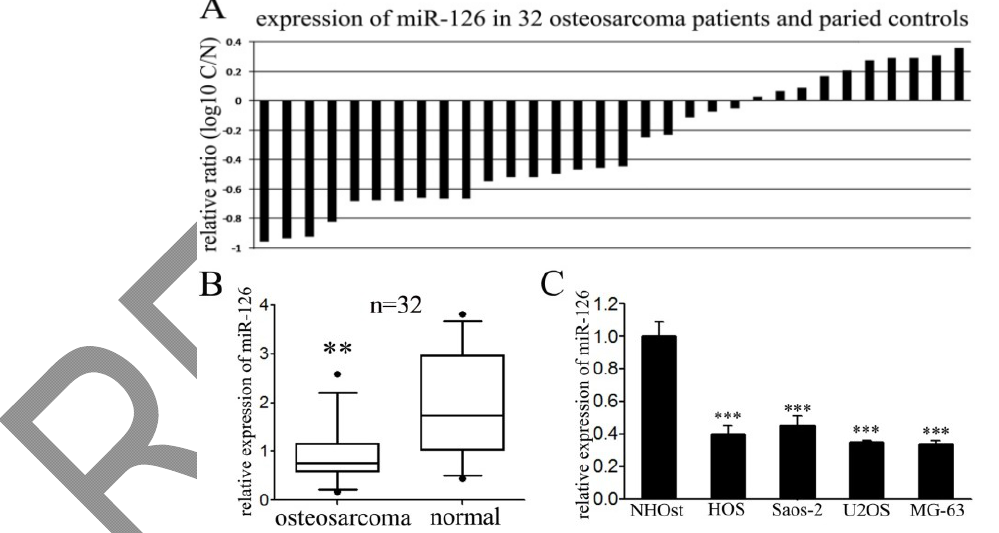
Figure 1. The expression of miR-126 in osteosarcoma tissues and cell lines. ( A ) The expression of miR-126 in 32 pairs of OS tissues and adjacent normal bone tissues was detected by TaqMan quantitative RT-PCR. Data are shown as log10 of relative ratio change of OS tissues relative to normal bone tissues. 68.7% of the patients showed the under-expression of miR-126 relative to normal tissues; ( B ) Statistical analysis of relative miR-126 expression levels in OS tissues and compared normal tissues. Compared with normal bone tissues, the expression of miR-126 in tumor tissues was significantly down-regulated; and ( C ) Using RT-PCR analysis, the expression of miR-126 in four OS cell lines (HOS, Saos-2, U2OS and MG-63) was analyzed. The expression of miR-126 in these OS cell lines was under-regulated relative to normal osteoblast cells